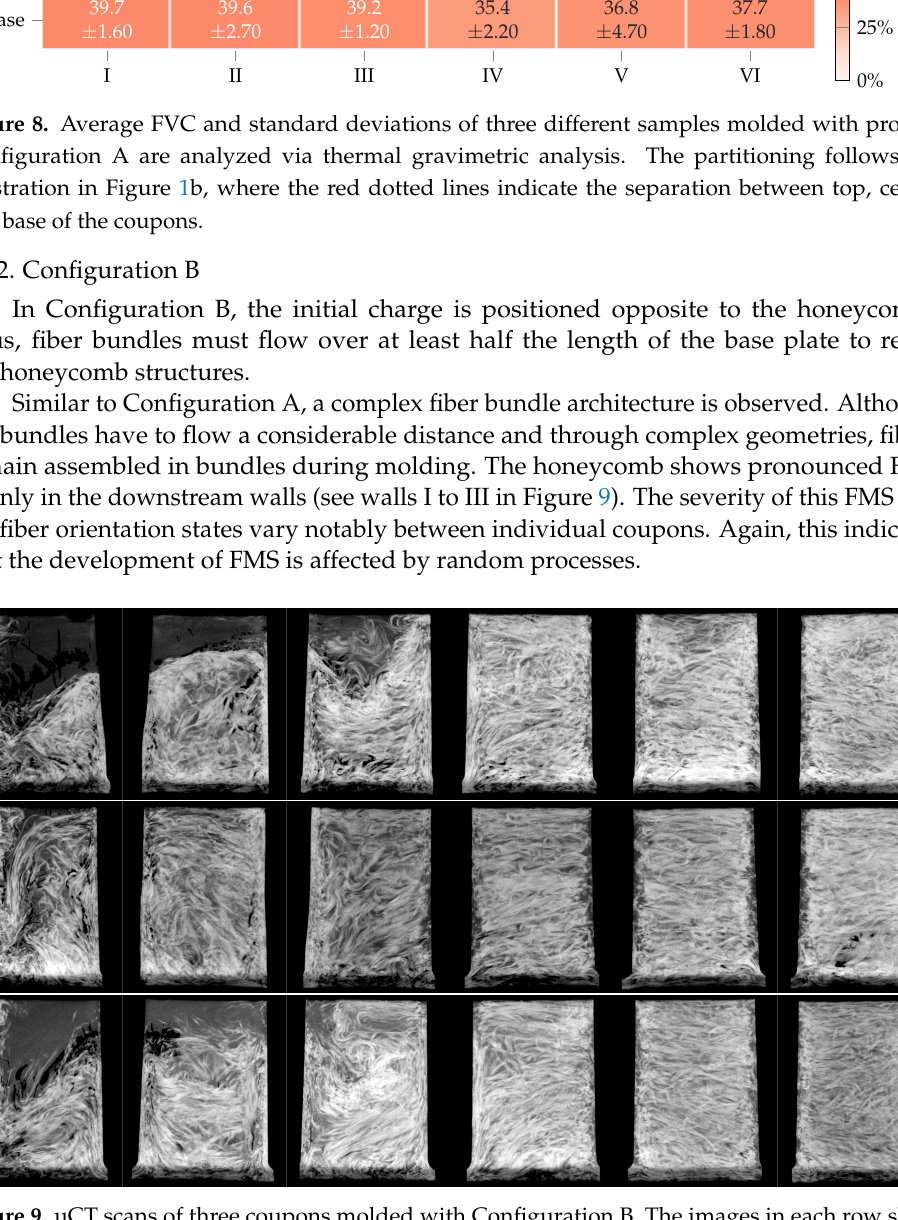
Figure 9. µCT scans of three coupons molded with Configuration B. The images in each row show the walls numerated I to VI from left to right